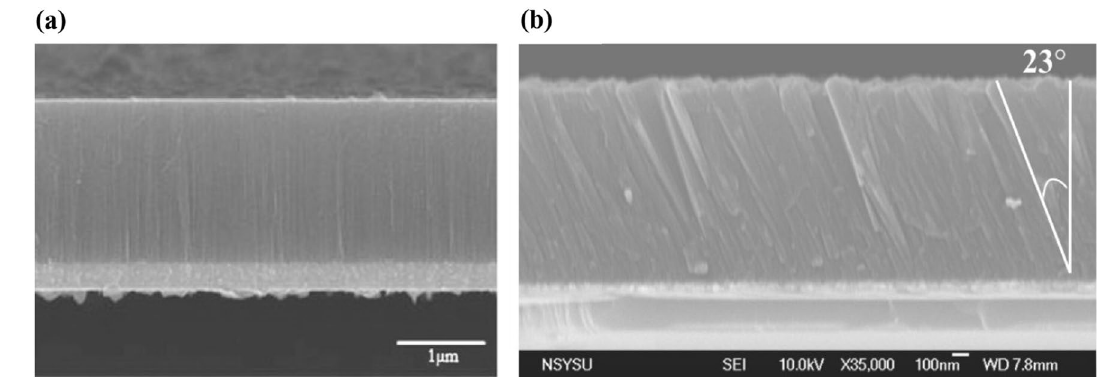
Fig. 13 SEM images of the piezoelectric thin film ( a ) cross-sectional view of AIN in the longitudinal mode, produced by [351] ( b ) cross-sec- tional view of AIN in the f shear mode produced by